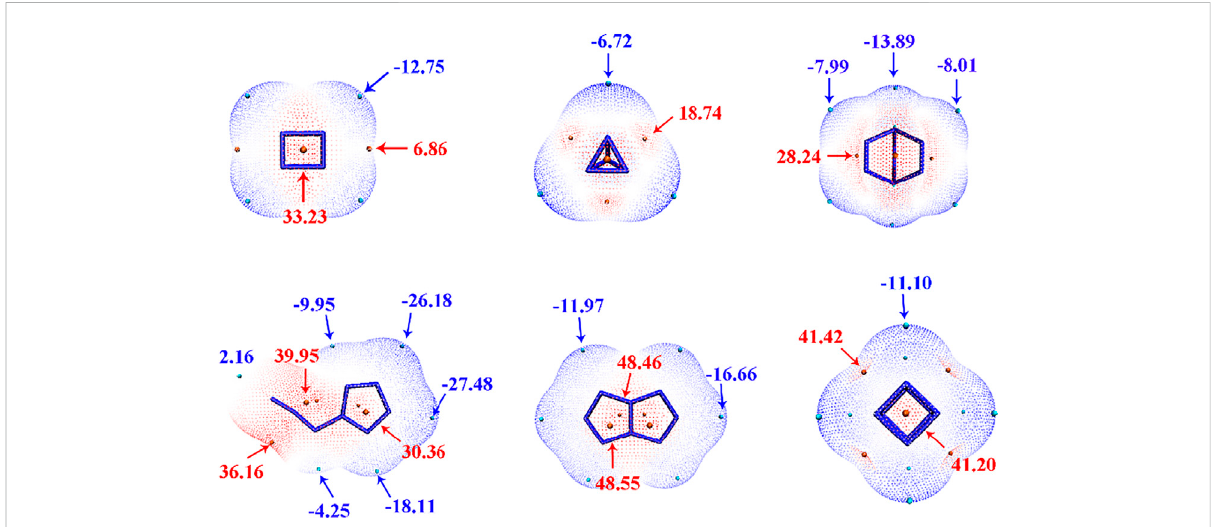
FIGURE 2 Electrostaticsurfacepotentials mappedmolecularvdWsurfaceof N 4 -1,N 4 -2, N 8 -1,N 8 -2, N 8 -3, and N 8 -4 .Signi fi cantsurfacelocalminimaand maxima of ESP are represented as orange and cyan spheres, and labelled by dark blue and red texts, respectively. The unit is in kcal/mol.